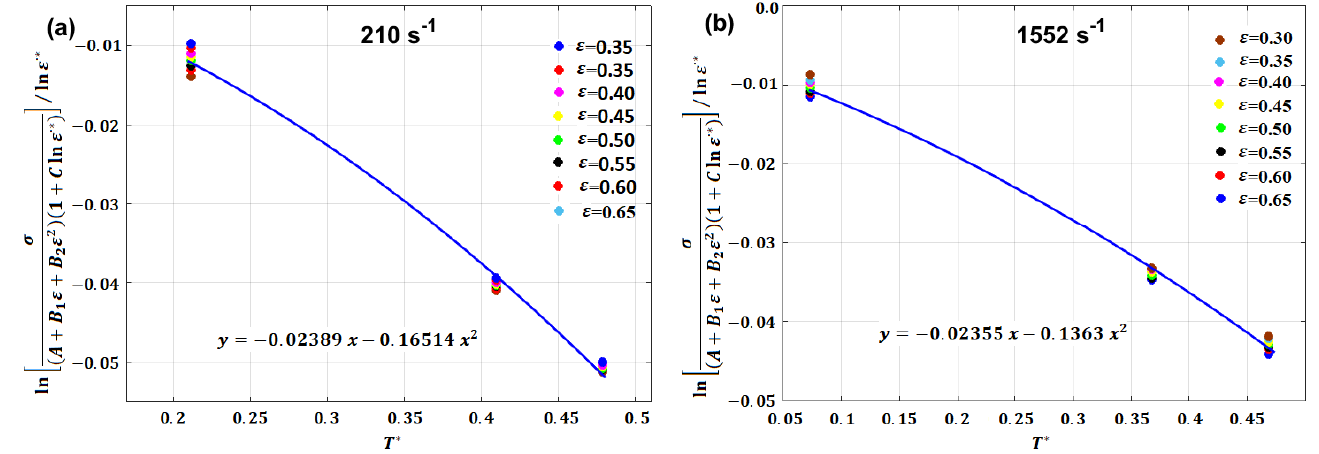
Figure 26. Determination of constants λ 1 and λ 2 at ( a ) 210 s − 1 and ( b ) 1252 s − 1 . The modified JC model that was introduced by Song et al. [81] provided a good those obtained using the original JC model (cf. Figure